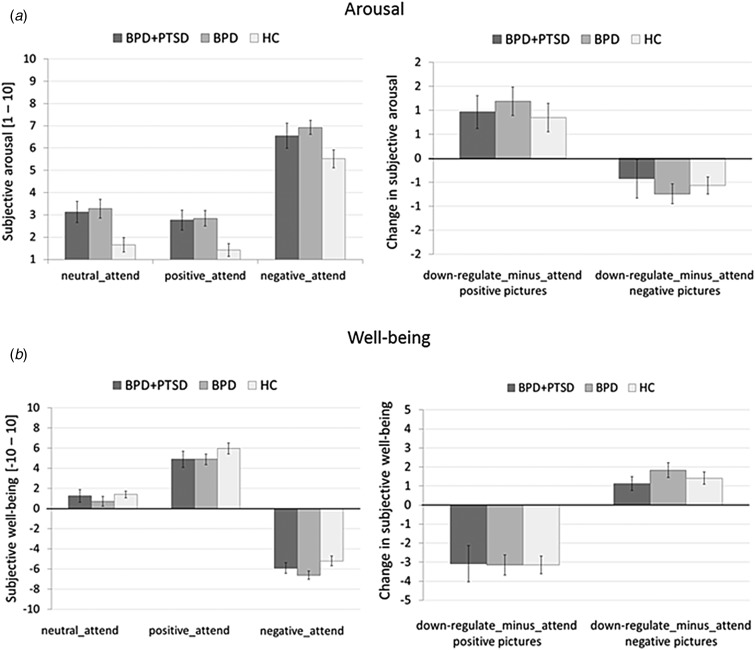
Means and standard errors of the mean of subjective ratings for arousal (a) and emotional well-being (b) in patients with BPD + PTSD, BPD patients without comorbid PTSD (BPD), and HC during the ER task. The left graphs depict arousal ratings for neutral, positive, and negative pictures in the passive viewing conditions (negative_attend, positive_attend, neutral_attend, and emotional reactivity). The right graphs illustrate changes in ratings for the ‘down-regulate’ minus ‘attend’ condition (regulate_minus_attend_negative, regulate_minus_attend_positive, and ER).